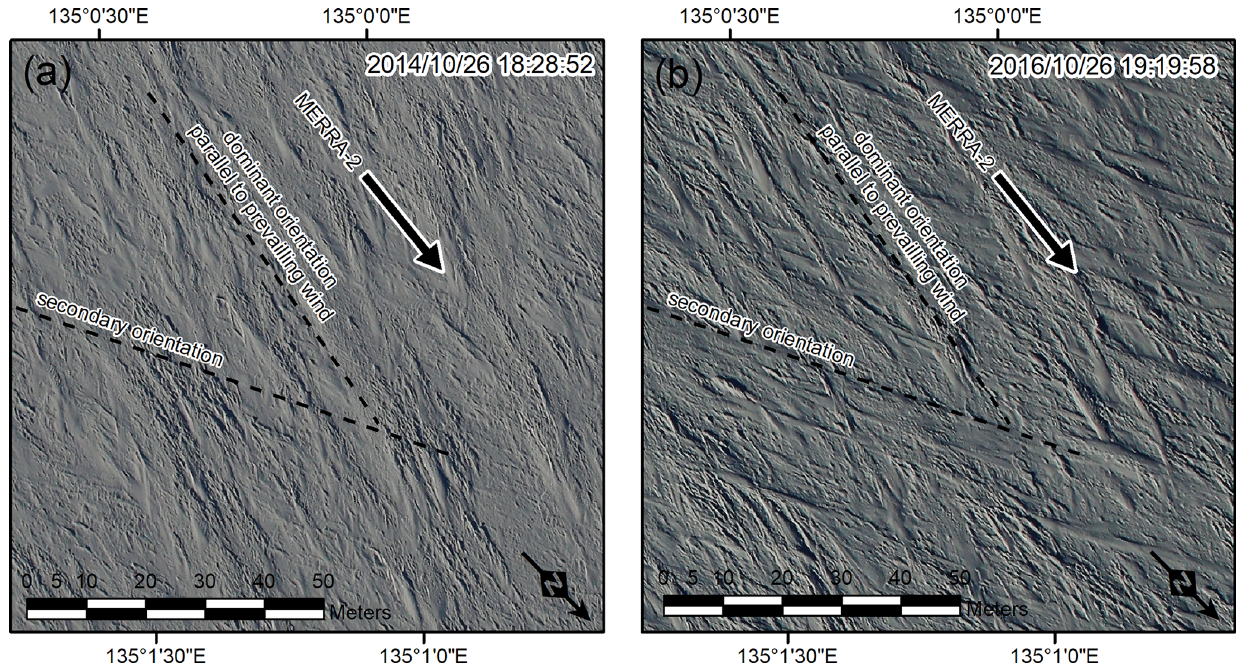
Figure 2. DMS natural color images of the same area at 88 ◦ S and 135 ◦ E. The location is indicated in Fig. 3b. The two aerial images are nadir- looking, geolocated, and orthorectified color photographs of a sun-illuminated snow surface taken from 460ma.g.l. The two photographs were taken on the same day of year 2 years apart. The low-angle sun illuminates the elongated, elevated surface features (sastrugi) facing the sun and creates dark shadows in the opposite direction behind the elevated features. For the 2014 image the sun is 11.5 ◦ above the horizon (accounting for refraction through the atmosphere) and for the 2016 image it is 12.1 ◦ . The orientations of sastrugi, indicated by dashed lines, are determined by visually following transitions of elongated bright, sun-illuminated features and corresponding shadows. Both images show a dominant sastrugi orientation parallel to the 26-year averaged 10m wind field from MERRA-2 (e.g., Gelaro et al., 2017) and a secondary orientation that appears to be less pronounced in 2014 compared to 2016. Table 1. Science instruments and airborne platforms of six NASA OIB aerogeophysical survey flights at 88 ◦ S. Date Longitude segment Aircraft Laser Snow & Ku-band radars Camera Flight elevation 23 Oct 2014 110 ◦ E to 70 ◦ W DC-8 ATM-T4 KU CReSIS DMS 460ma.g.l.